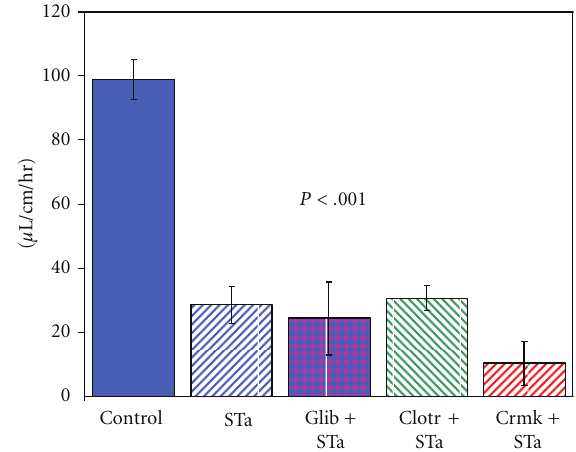
Figure 2: The e ff ect of intravenous perfusion by jugular vein of glibenclamide ( n = 6) at 7.0mg/kg/hr, clotrimazole ( n = 5) at 2.85mg/kg/hr, and cromakalim ( n = 5) at 2.72mg/kg/hr on net fluid absorption from the proximal jejunum of the rat in vivo perfused luminally with 80ng/mL E. coli STa heat stable enterotoxin. For comparison, fluid absorption without perfusion with STa ( n = 14) and with perfusion with STa ( n = 17) are given. Fluid absorption in the presence of STa was significantly lower ( P < . 001) than control values. I.v. perfusion of the indicated potassium channel active agents in the presence of STa was not significantly di ff erent from STa perfusion